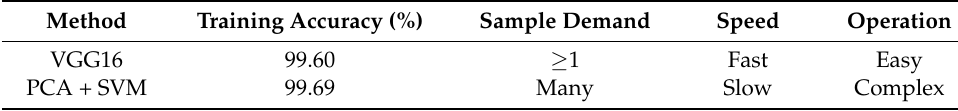
Table 4. Comparison results between VGG16 and PCA +